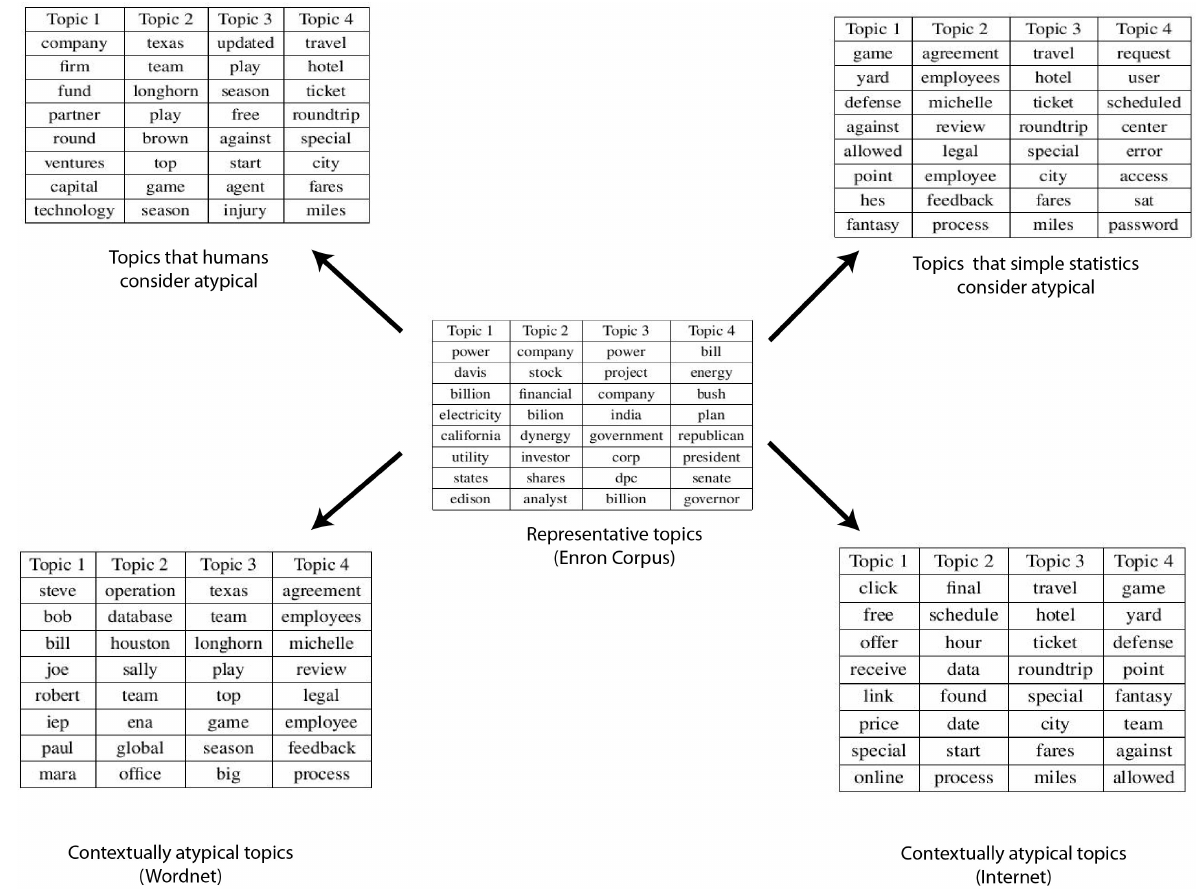
Figure 4. Results from Enron dataset. Table in the center shows the most representative topics, table in the upper left corner shows the human adjudged anomalies, table in the upper right corner shows the statistical anomalies and tables in the bottom show the final contextual anomalies based on WordNet (left) and Internet (right),